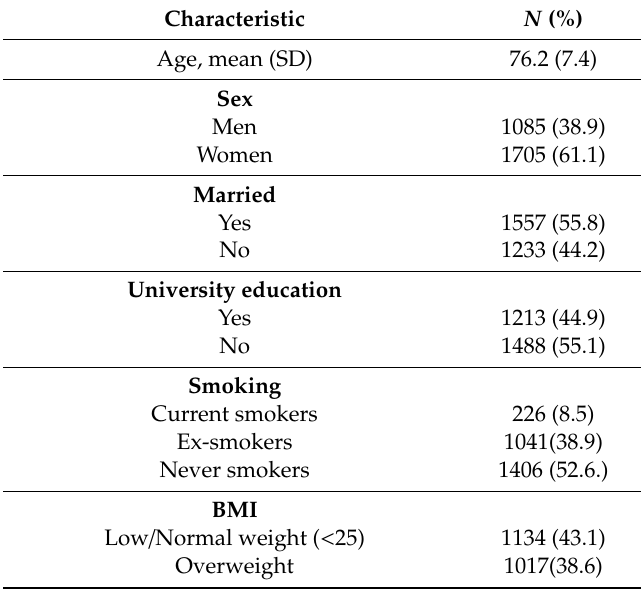
Table 1. Descriptive characteristics of the